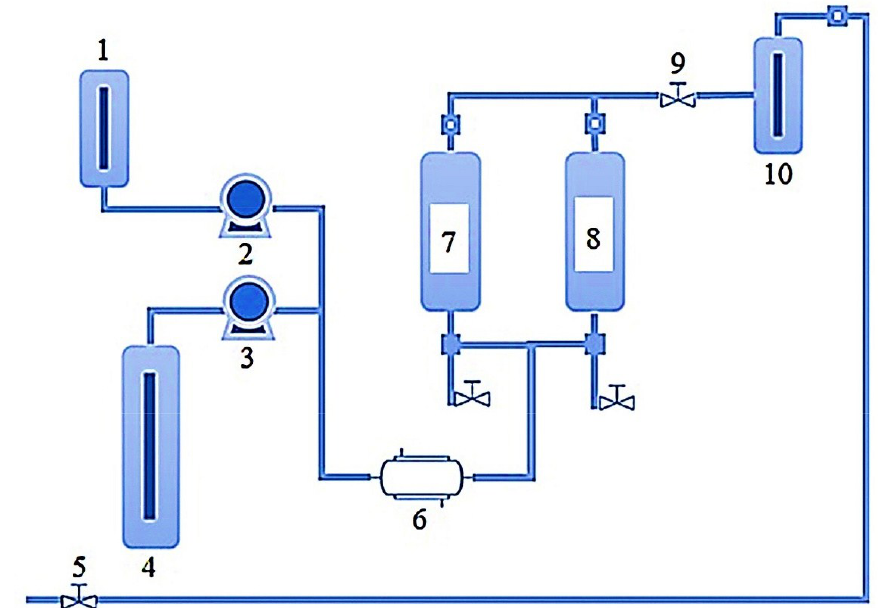
Figure 3. A schematic representation of SFE equipment and working conditions [where: 1: Co-solvent vessel; 2: Co-solvent pump; 3: CO 2 pump; 4: CO 2 tank; 5: Manual BPR; 6: Heat exchanger; 7: Extraction vessel 1; 8: Extraction vessel 2; 9: Automated BPR; and 10: Collection vessel]. Reproduced from García‐Pérez et al. [47], with permission from Elsevier.